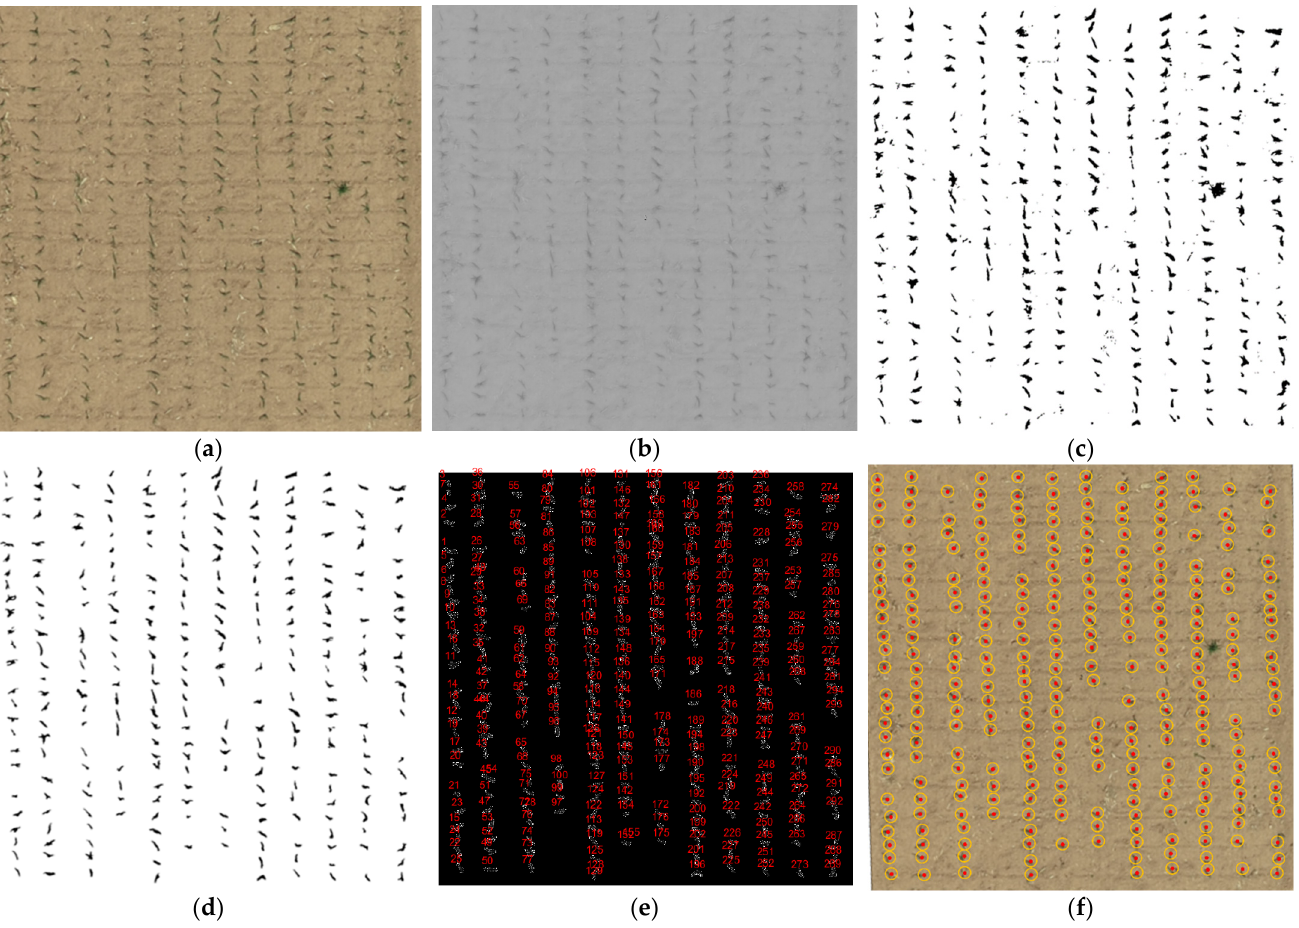
( b ) Figure 13. The maximum elevation of LiDAR data, the elevation of DTM, and the estimated height: ( a ) A1, ( b ) A2. 3.3. Quantitative Analysis of Height Estimation Accuracy The height estimation errors of the two cultivars (A1, A2) were analyzed to assess the algorithm performance at each of the different growth stages. The distributions of the er- rors for the 289 maize plants at the jointing, tasseling, and mature stages are shown in Figure 14a–c, respectively, with the horizontal axis of difference between the estimated height and the field-measured height (ground truth). Plant trait surveys were completed on the day of the aerial photography by researchers from the Cultivation and Physiology Research Unit of the Maize Research Institute of Shanxi Agricultural University, who pro- vided the measured plant height data (as shown in Table 3). The accuracies of the maize plant height estimation are shown in Table 4.